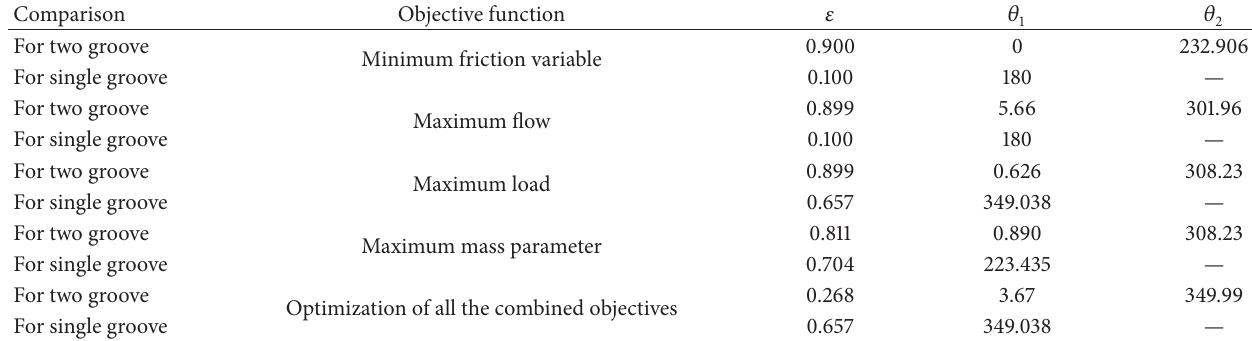
Table 7: Comparison of optimum locations of grooves for two-groove and single-groove bearings.